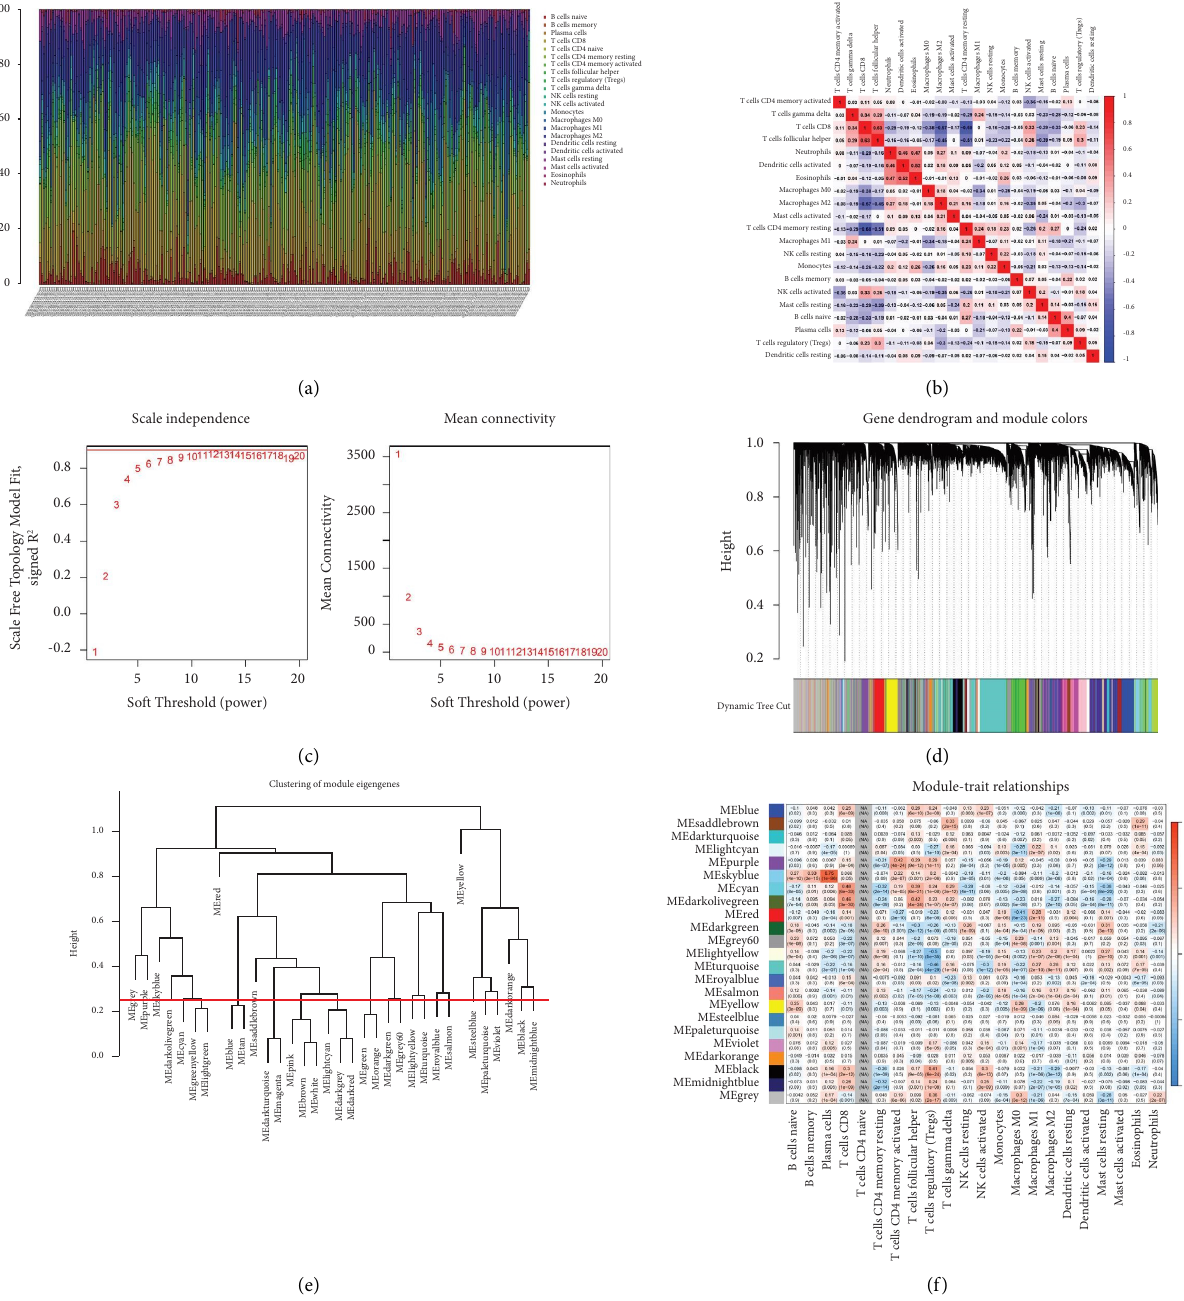
Figure 1: (a) Te heatmap demonstrated the immune cell infltration between RCC tissues and normal renal tissues; (b) the correlation analysis between diferent immune cells; (c) the threshold for screening determines whether two genes have similar expression patterns; (d, e) the clustering tree shows diferent gene modules as diferent branches, and the colors show diferent modules as diferent colors; (f) the results of WGCNA shows the correlation between module genes and immune